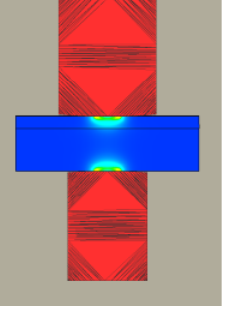
Figure 9. Digital twin model input data, ( a ) welding current, ( b ) force of electricity.